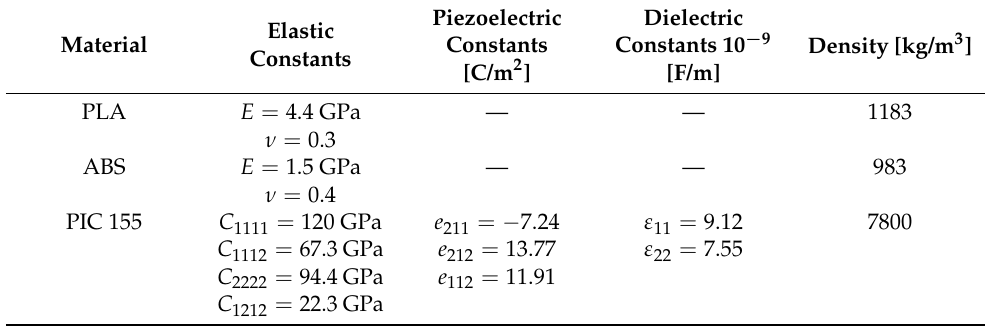
Table 1. Material properties used in the numerics.